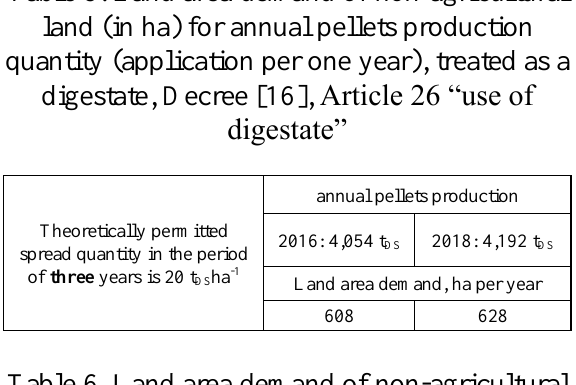
Table 6. Land area demand of